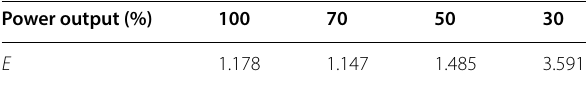
Table 4 Dependence of the flexibility on the power